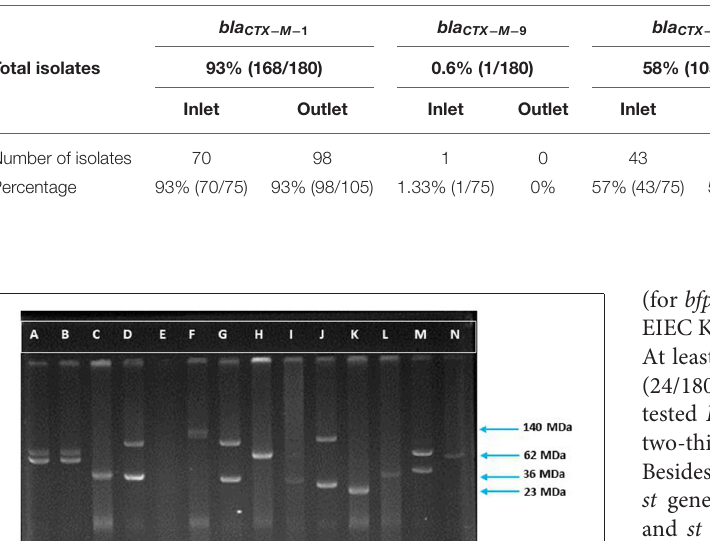
TABLE 1 | Presence of bla genes in ESBL positive E. coli isolates detected via PCR.